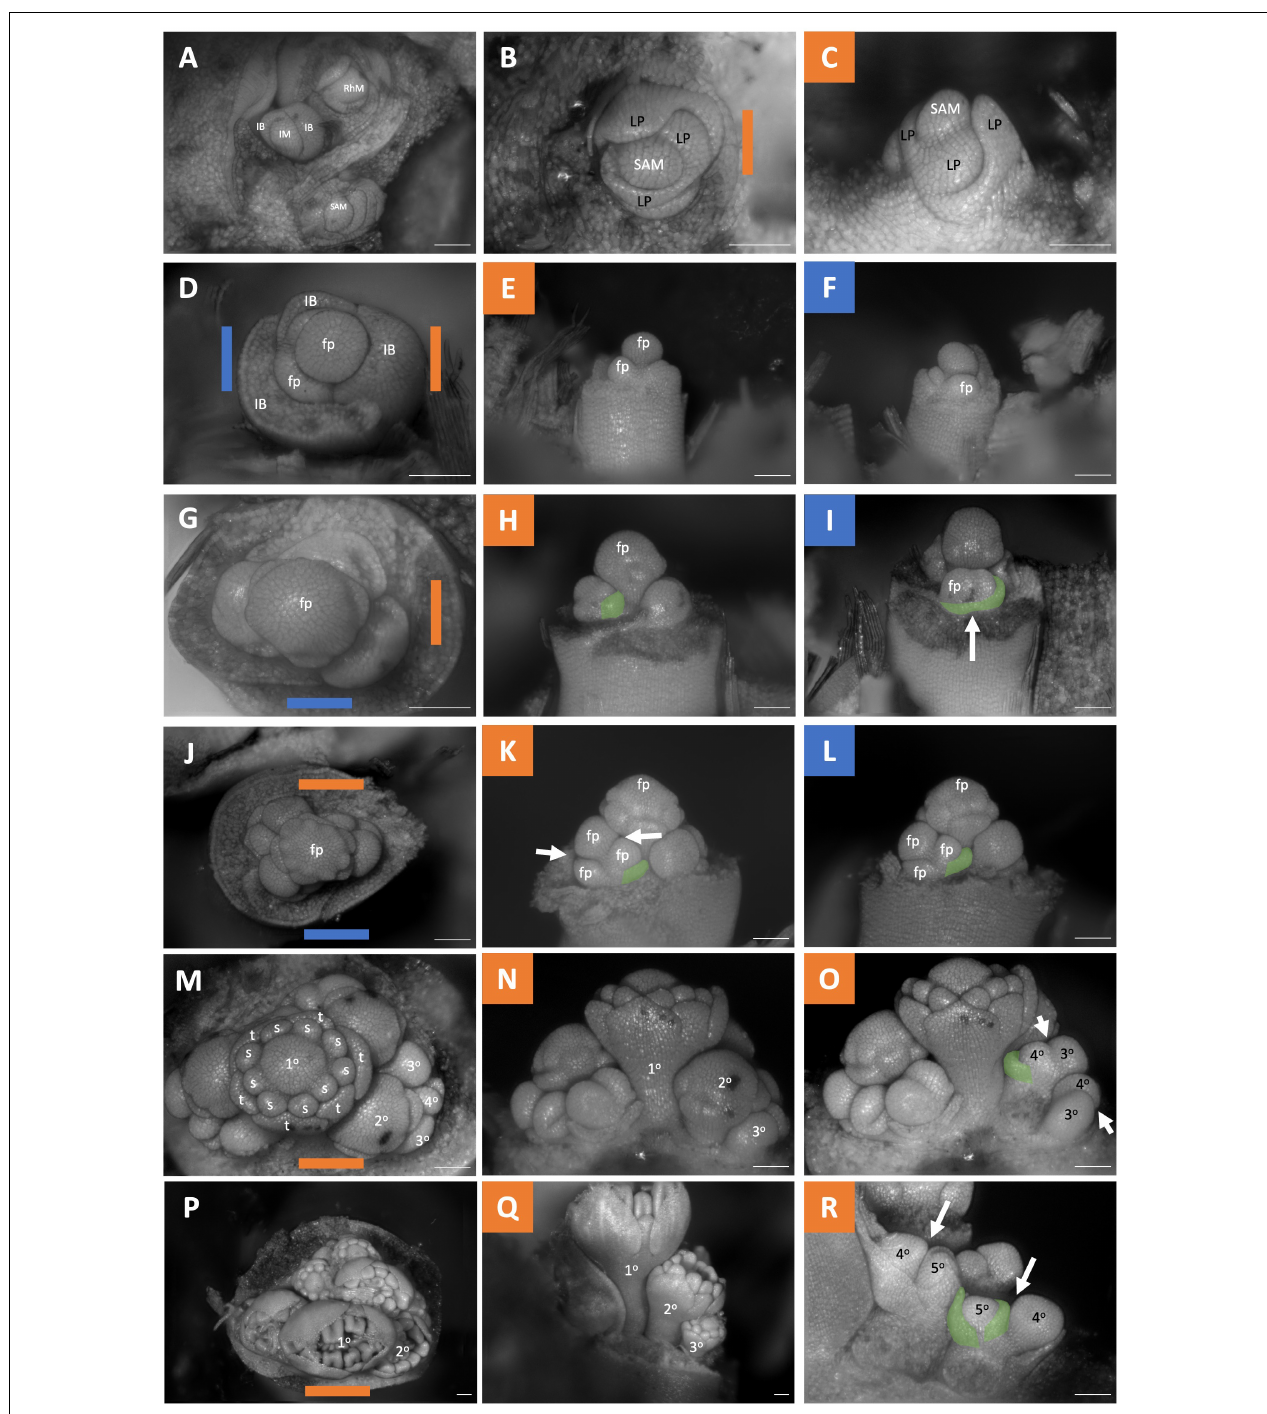
FIGURE 7 | Butomus umbellatus inflorescence developmental morphology. (A) Leading end of rhizome including three meristems. Shoot Apical Meristem, Inflorescence Meristem, Rhizome meristem. (B,C) SAM, (B) SAM imaged from the apex. (C) SAM imaged laterally. (D–R) Five stages of inflorescence development (rows). The meristems in the first column (D–P) are imaged from the apex. The second and third columns are imaged laterally. (D–F) Inflorescence with three inflorescence bracts formed, the oldest inflorescence bract (left) removed, and the second oldest inflorescence bract (right) removed in (E) . (G–I) Inflorescence where the first whorl of tepal primordia arise. (J–L) Apical flower with nine stamen primordia. (M–O) Inflorescence with nine stamen primordia fully formed, gynoecium developmental about to initiate. (P–R) Inflorescence with gynoecium development. Branching order (1 ◦ –5 ◦ ) labeled for one of the three cymes (M–R) . Colored lines on images taken from the apex (B–P) indicate orientation of the inflorescence in subsequent panels. SAM, shoot apical meristem; IM, inflorescence meristem; RhM, lateral rhizome meristem; LP, leaf primordia; IB, Inflorescence bract; fb, floral bract, false colored green (H–I,K–L,O,R) fp, floral primordia; t, tepal primordia; s, stamen primordia. White arrows indicate branching events. Scale bar for all images: 100 µ m.